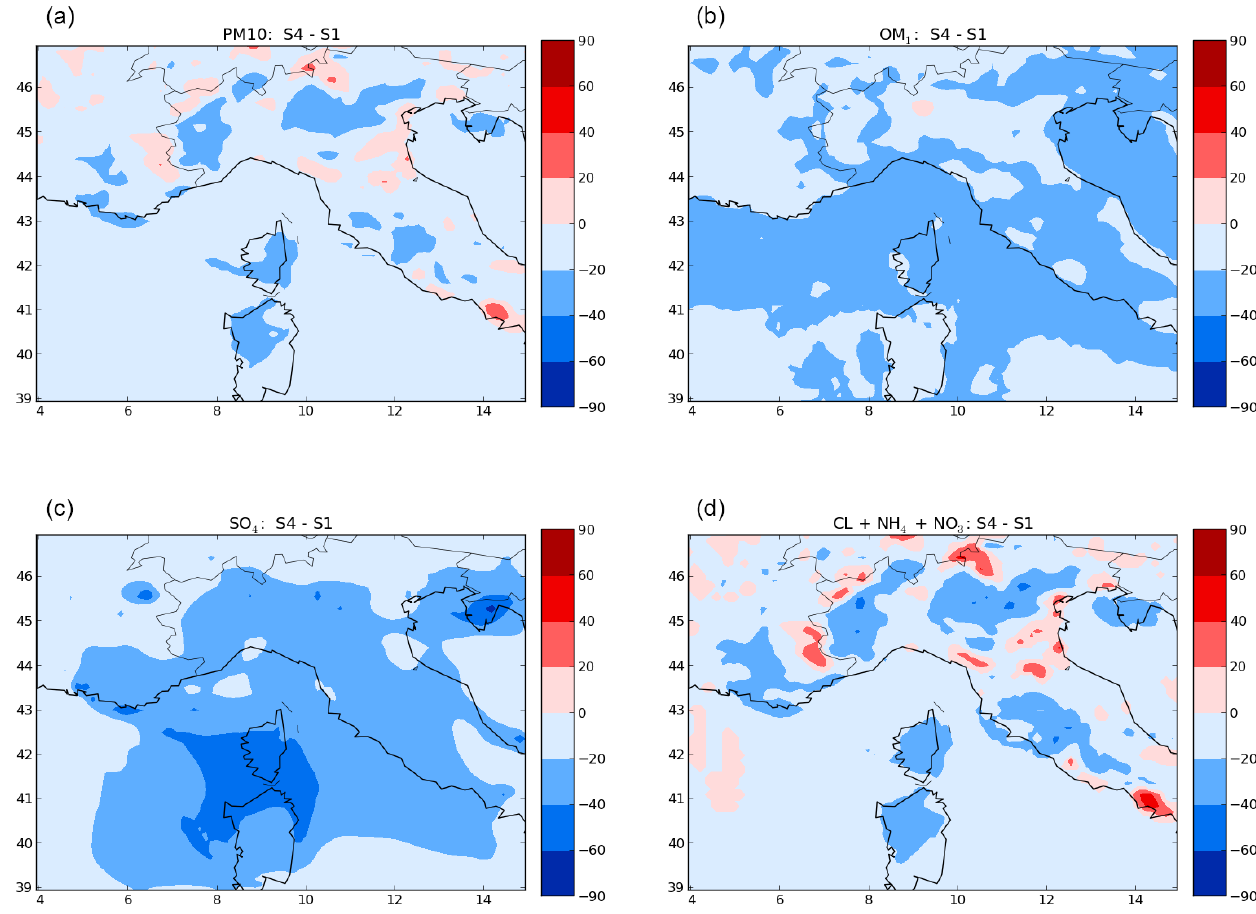
Figure D4. Maps of the relative differences of the concentrations of PM 10 (a) , OM 1 (b) , sulfate (c) and other inorganics (nitrate, ammonium and chloride) (d) in % between S1 and S4 (b, d) during the summer 2013.